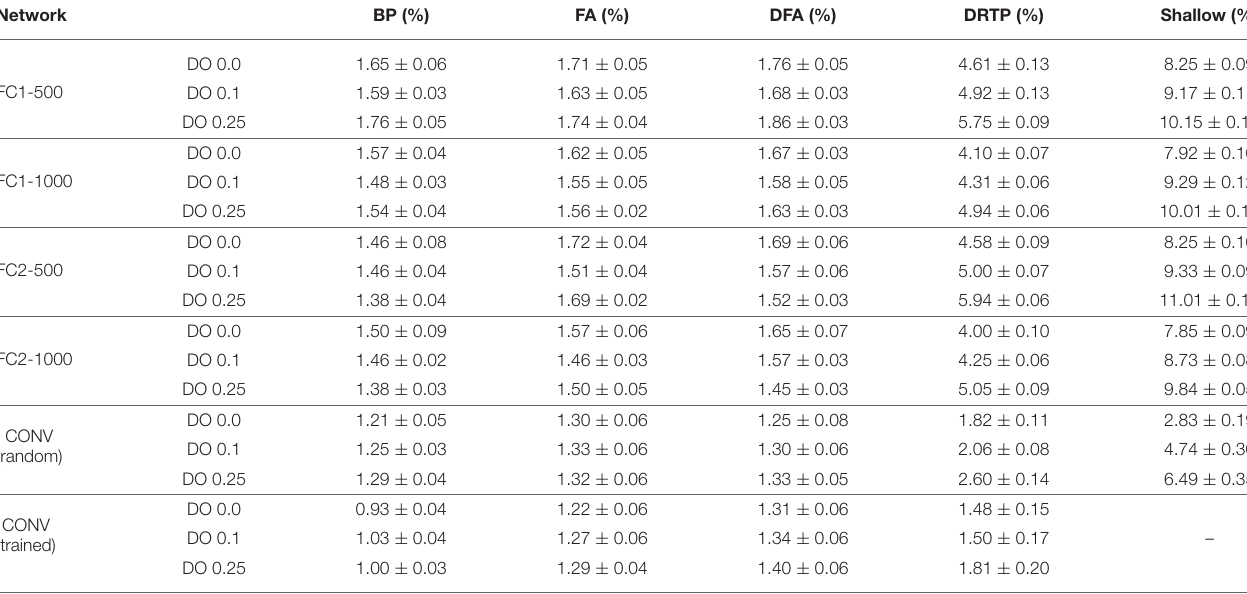
TABLE 1 | Mean and standard deviation of the test error on the MNIST dataset over 10 trials. Network BP